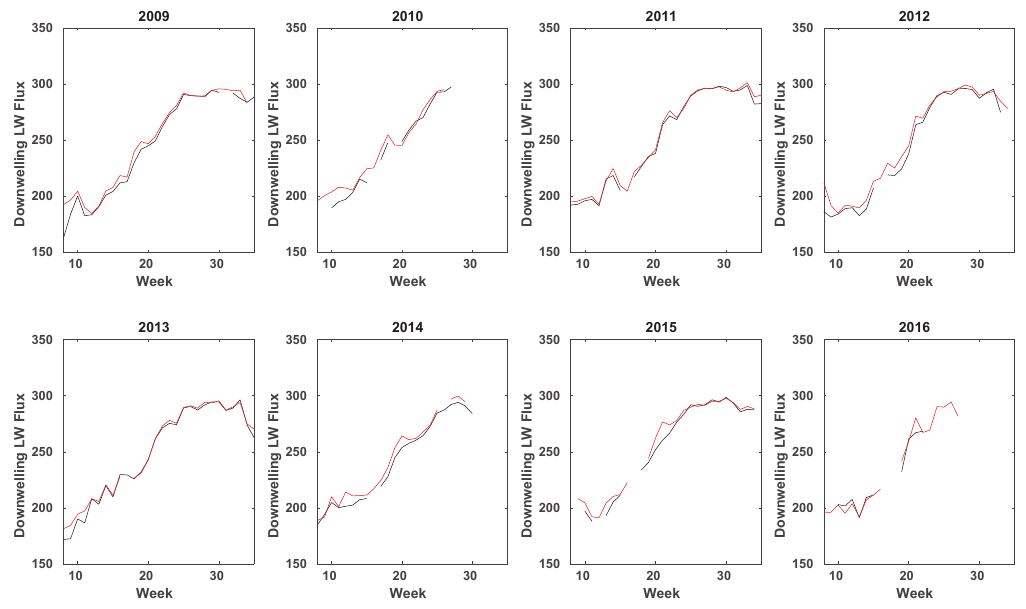
Figure 9. Mean downwelling longwave radiation in W/m 2 for surviving ( black ) and melted ( red ) parcels during 2009–2016.